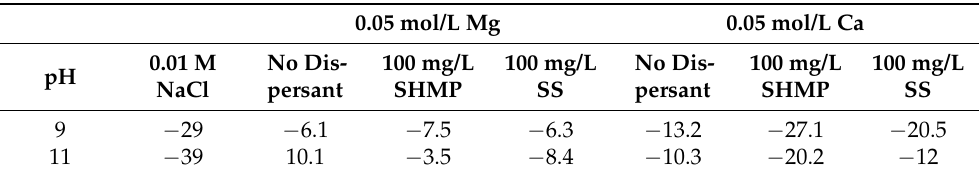
Table 3. Effect of SHMP and SS on the zeta potential of chalcopyrite (mV) in aqueous solutions of magnesium and calcium, at pH 9 and 11.